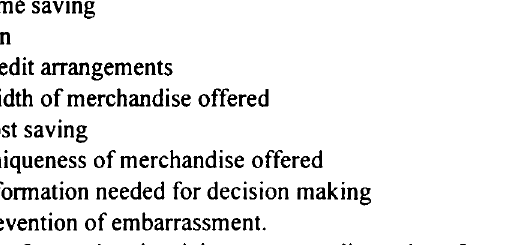
Table 5 Comparison of 8- and 11-factor